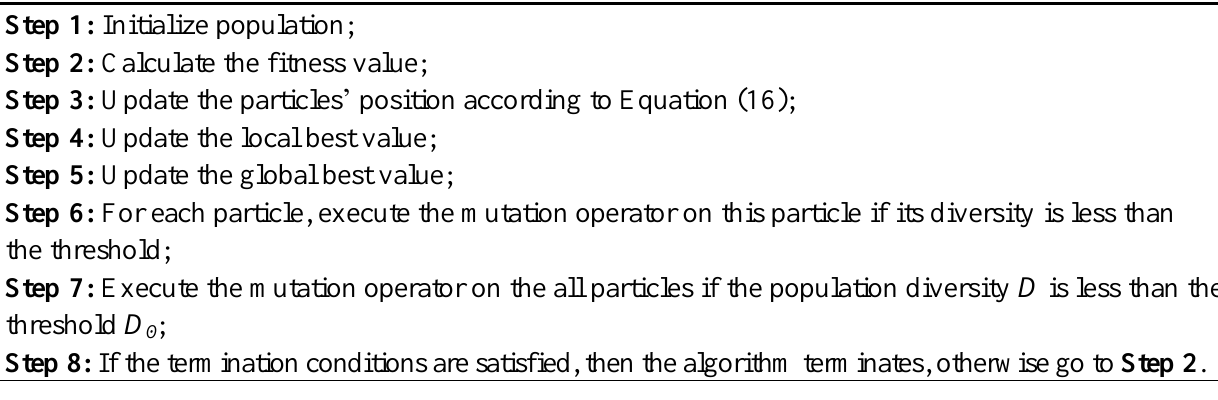
Algorithm 1. The Discrete PSO Algorithm for DA Model of Task Allocation